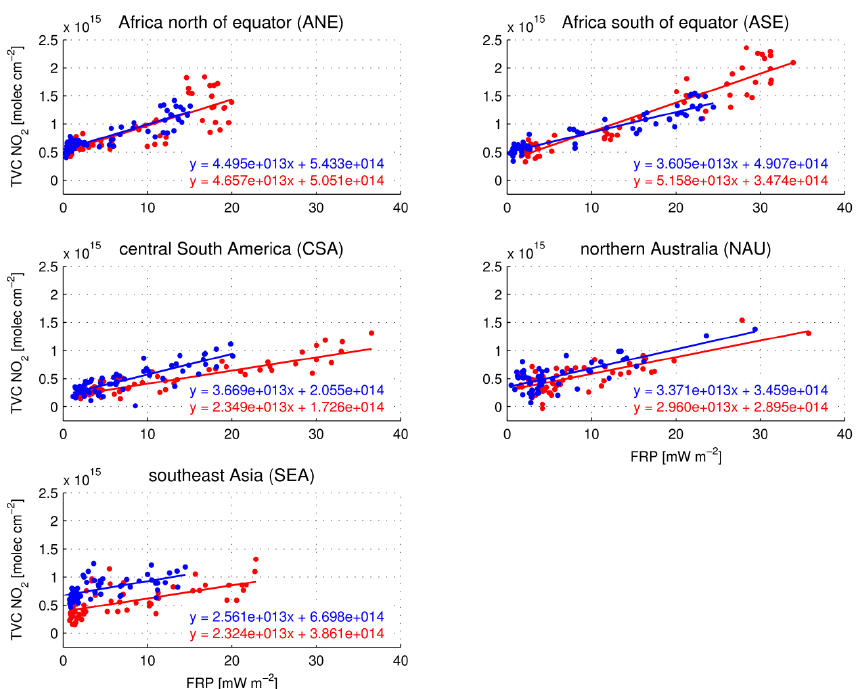
Figure 4. Scatter plots with their associated regression coefficients for the selected regions, illustrating the linear relationship of GOME-2 TVC NO 2 vs. MODIS Terra FRP (blue) as well as OMI TVC NO 2 vs. MODIS Aqua FRP (red). Each dot represents a monthly average over the respective region.